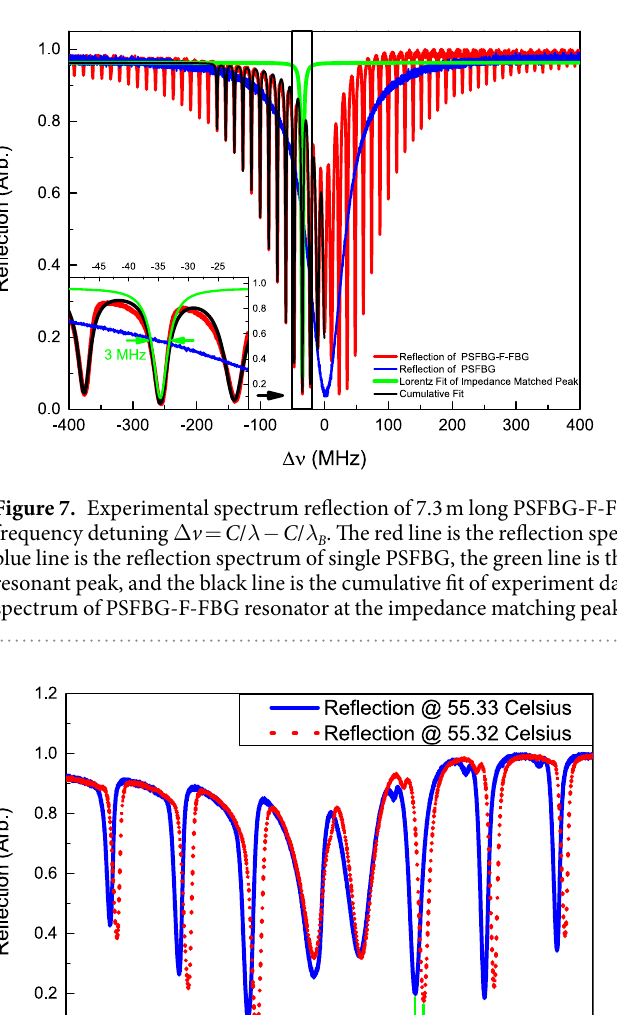
6.46 × 10 − 6 °C − 1 , almost the same with the value mentioned before), and a 0.01 °C temperature change equals 12.5